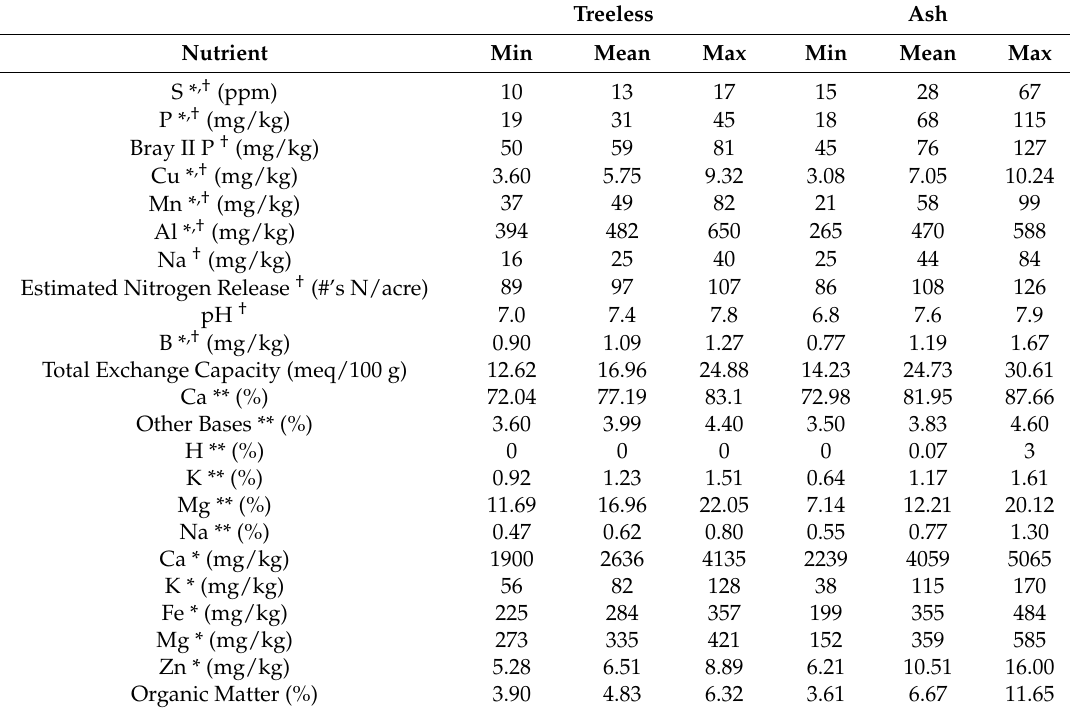
Table 3. The mean, minimum (min) and maximum (max) for nutrient amounts with significant test results.